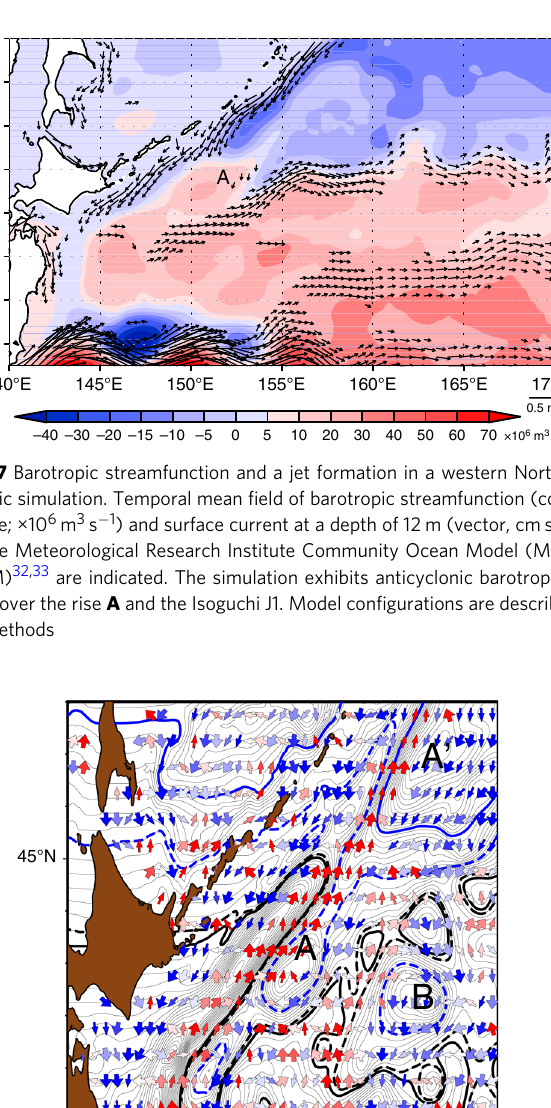
, as well as R 2 d